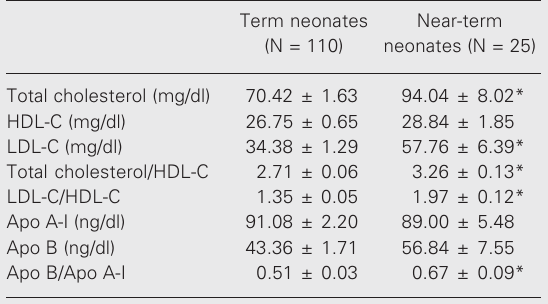
Table 3. Lipids, apolipoproteins and atherogenic indexes of